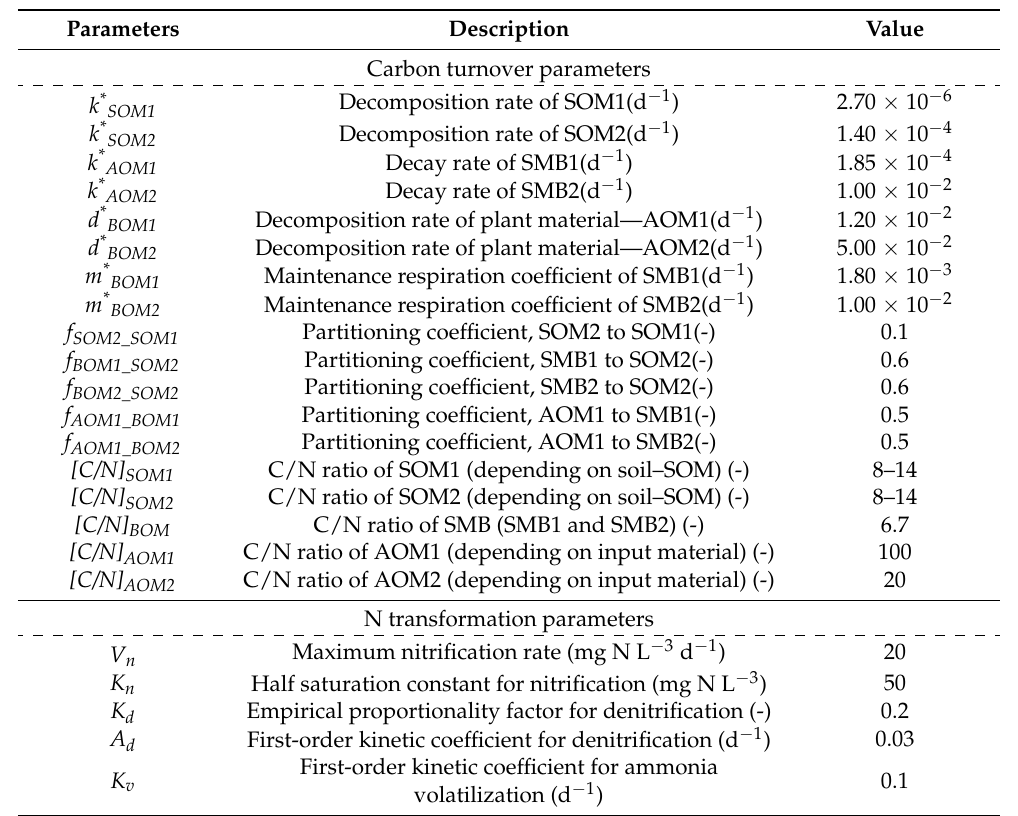
Table 2. Soil carbon and nitrogen transformation